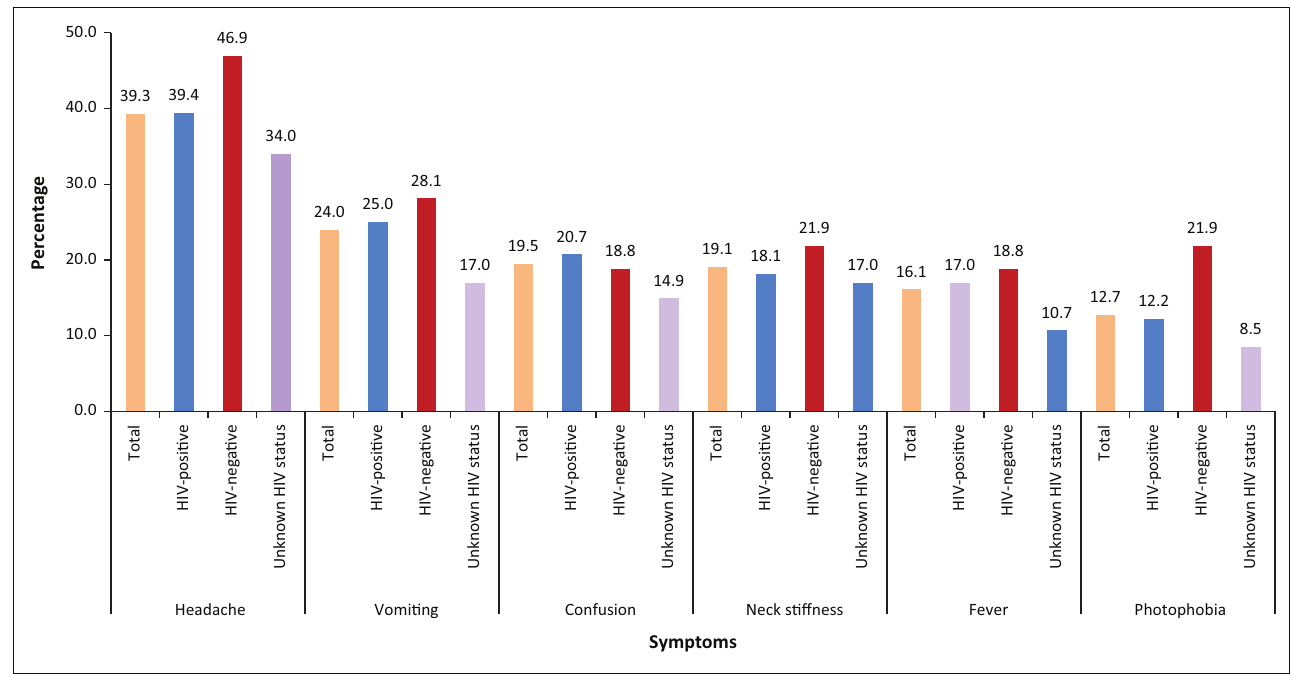
HIV, human immunodeficiency virus. FIGURE 1: Presenting symptoms in all patients versus HIV-positive, HIV-negative and patients with unknown HIV